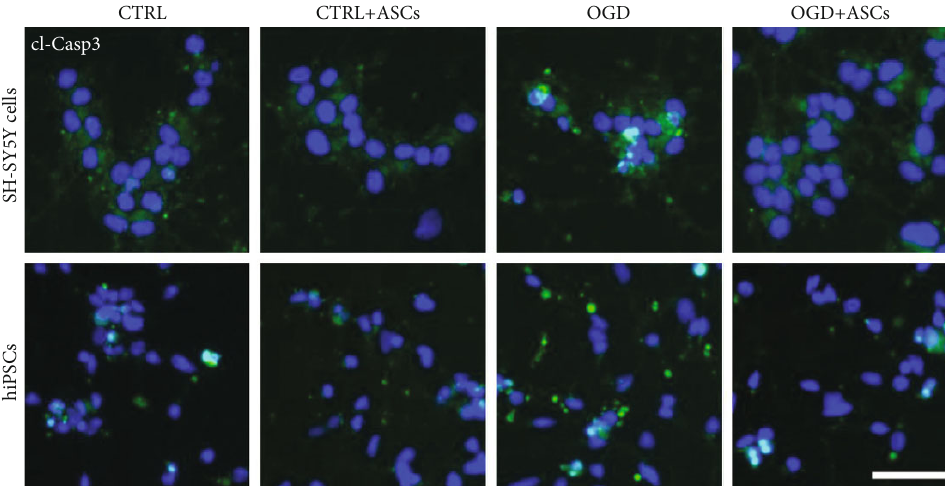
Figure 4: Apoptosis of SH-SY5Y- and hiPSC-neurons after OGD and ASC coculture, as determined by cleaved caspase-3 (cl-Casp3) staining. Representative images of cl-Casp3 staining after 72h of reperfusion in SH-SY5Y-neurons ( n = 1 /group/experiment, representative image of two to four separate experiments; two to four images were taken of each well) and hiPSC-neurons ( n = 1 /group/experiment, representative images of two separate experiments; 4 images were taken of each well). Blue =nuclei; green =cl-Casp3. Scale bar, 50 μ